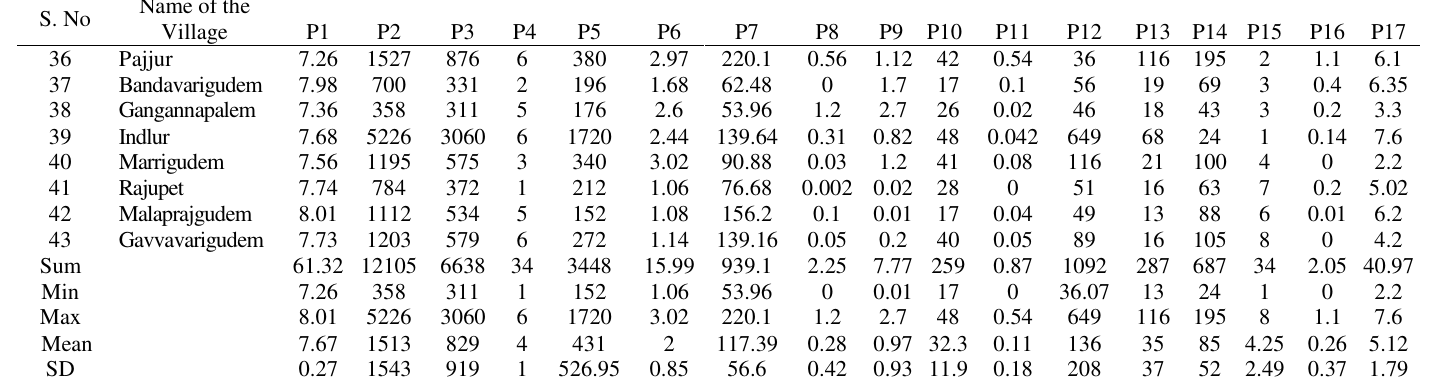
Table 3. Physicochemical analysis of open well